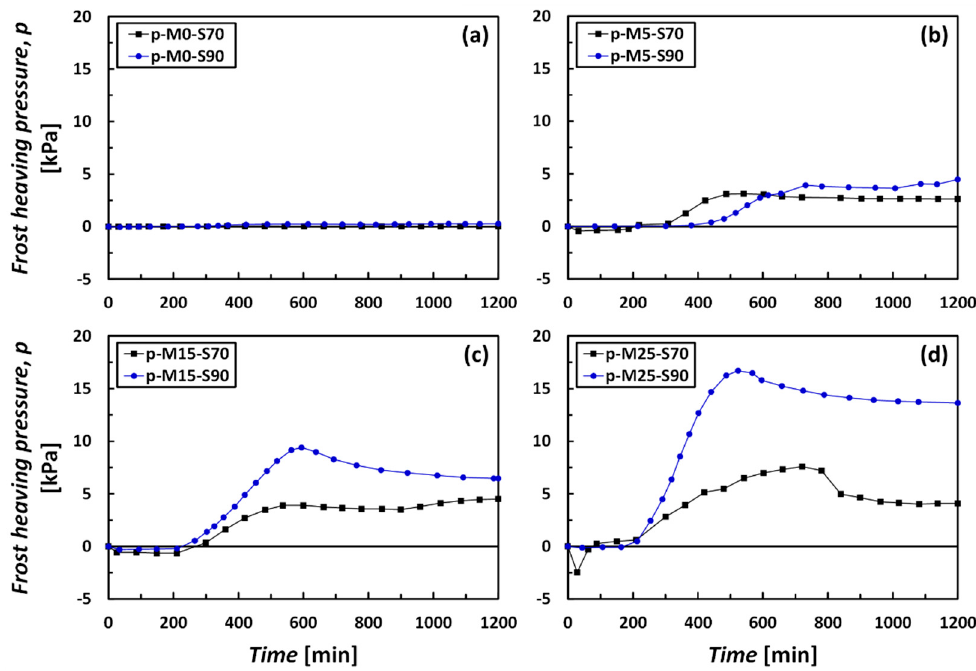
Figure 7. Results of frost heaving pressure tests. ( a ) M = 0%, ( b ) 5%, ( c ) 15%, and ( d ) 25%. The minimum value in the p ( − 2.5 kPa) was observed at t = 28.5 min for